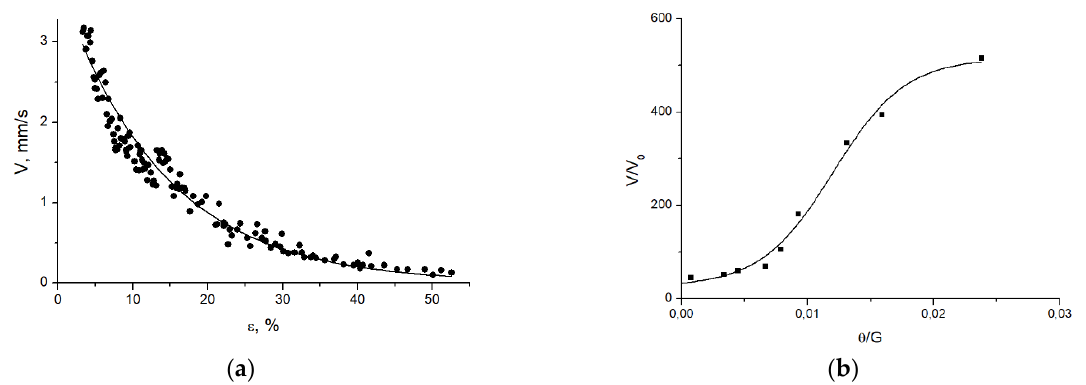
Figure 5. ( a ) Propagation velocity V of PLC bands vs. total deformation ε ; ( b ) relative velocity V / V 0 of PLC bands vs. work-hardening coefficient θ .